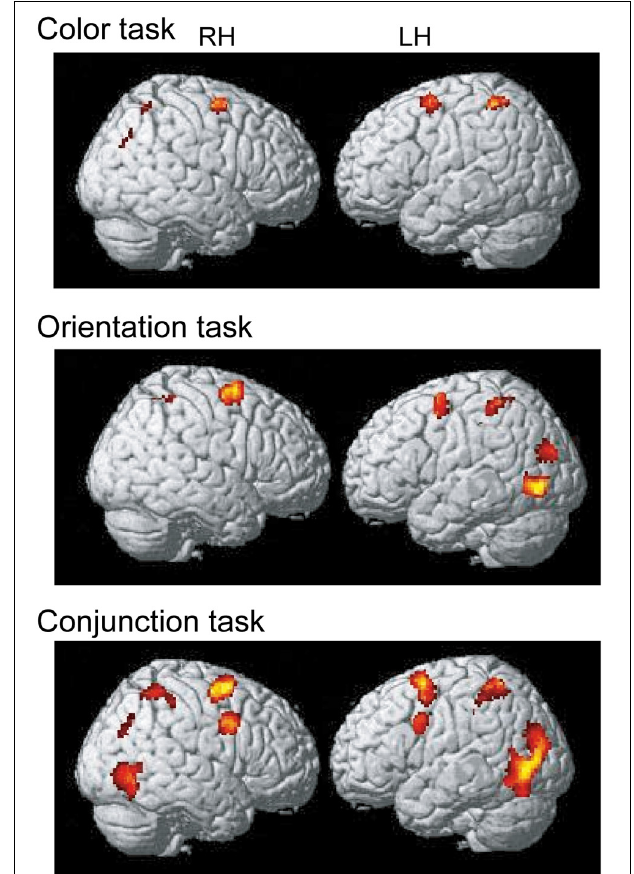
FIGURE 4 | Statistical parametric map of regions showing greater activation in the binding condition than in the control condition during the maintenance period, displayed on a surface-rendered standard brain. SPM{t} maps in the color task (upper panel), the orientation task (middle panel), and the conjunction task (bottom panel) ( p < 0 . 001, uncorrected, spatial extent threshold of 200 voxels). RH, right hemisphere, LH, left